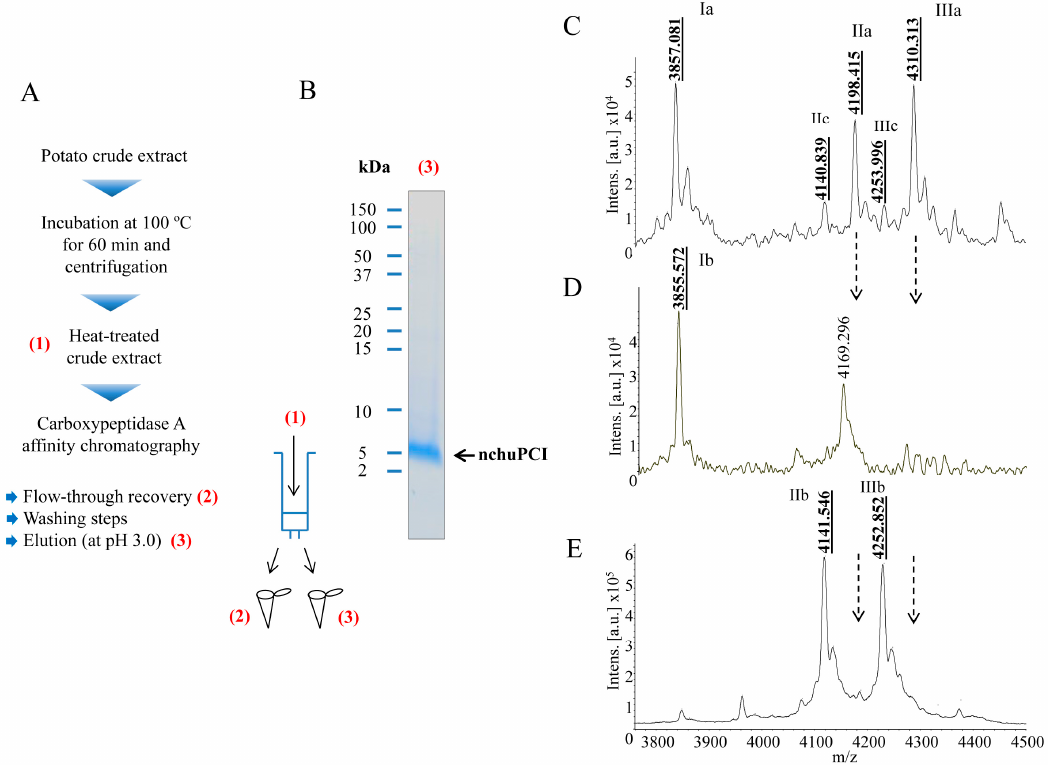
Figure 2. Purification and MALDI-TOF mass spectrometric analysis of a native carboxypeptidase inhibitor from Andean potatoes. ( A ) Schematic diagram of the one-step strategy followed for the purification of the native carboxypeptidase A inhibitor from potato tubers of S. tuberosum subsp. andigenum cv. Churqueña. Before purification, a crude extract of potato tubers was prepared and centrifuged. The clarified supernatant was incubated at 100 °C for 60 min. Once incubated, the sample was further centrifuged, and the resultant supernatant loaded onto an in-house prepared affinity resin for the specific purification of carboxypeptidase inhibitors; ( B ) Coomassie-stained tris-tricine-SDS-PAGE showing the purity of the final native protein. The location of the native chuPCI (nchuPCI) is indicated with an arrow; ( C – E ) MALDI-TOF mass spectra of ( C ) initial heat-treated crude extract, ( D ) unbound crude extract and ( E ) fraction eluted from the affinity chromatography. Numbers above the major peaks indicate the average mass of the MH+ ion ( m / z ). Note that the molecular mass is = mass of the MH+ − 1 Da. MALDI-TOF spectra were recorded on a Ultraflextreme MALDI-TOF mass spectrometer (Bruker Daltonics) operating in in a linear positive mode. In panels D and E, dotted arrows indicate the mass of the MH+ ion ( m / z ) of the two faded signals (4198.415 and 4310.313 Da, corresponding to the peaks IIa and IIIa, respectively, in panel C).